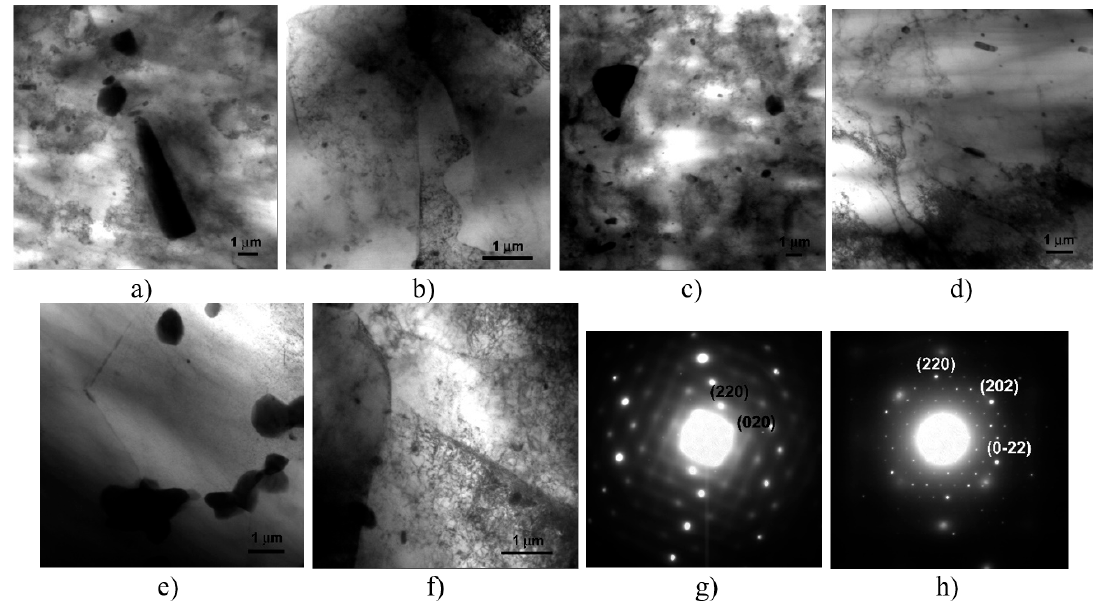
Figure 9. MnAl 6 dispersoids, Mg 2 Al 3 particles, and (Fe,Mn) 3 SiAl 12 intermetallic particles evolution with the different experimental conditions: ( a ) FSW 1 -A-CR, ( b ) A-FSW 1 -CR, ( c ) FSW 2 -A-CR, ( d ) A-FSW 2 -CR, and ( e ), ( f ) ECAP-1. ( g ) SAEDP of the MnAl 6 dispersoids, taken at the [001] matrix zone axis, and ( h ) SAEDP of the Mg 2 Al 3 particles taken at the [111] matrix zone axis. MnAl 6 was identified according to the JCPDS chart #6-665, as orthorhombic phase (S.G. C MCM /63) with a = 6.50 Å, b = 7.55 Å, c = 8.87 Å; Mg 2 Al 3 was identified according to the JCPDS chart #3-877, as cubic phase (S.G. C P3M /227) with a = 28.28 Å.